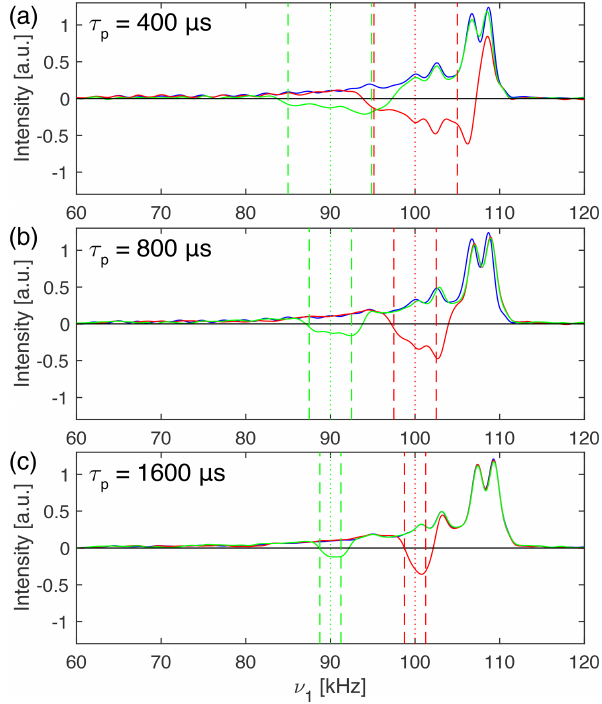
Figure 4. Proton nutation spectra of adamantane spinning at 20kHz at 500MHz proton resonance frequency using a Bruker 1.9mm MAS probe. In blue, a standard nutation experiment is shown with a nominal rf-field amplitude of 100kHz determined by the zero cross- ing of a 5µs π pulse. The nutation spectra in green and red were preceded by an I-BURP-2 pulse of length (a) 400µs, (b) 800µs and (c) 1600µs using a modulation frequency of 90kHz (green) and 100kHz (red), respectively. The fact that the inversion ranges are slightly shifted compared to the theoretical ones (indicated by dashed and dotted lines) is most likely due to fluctuations in the amplifier gain, as can be seen from Fig. S03.